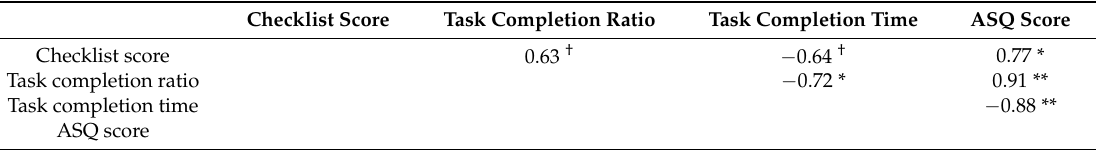
Table 6. Correlation coefficients among usability